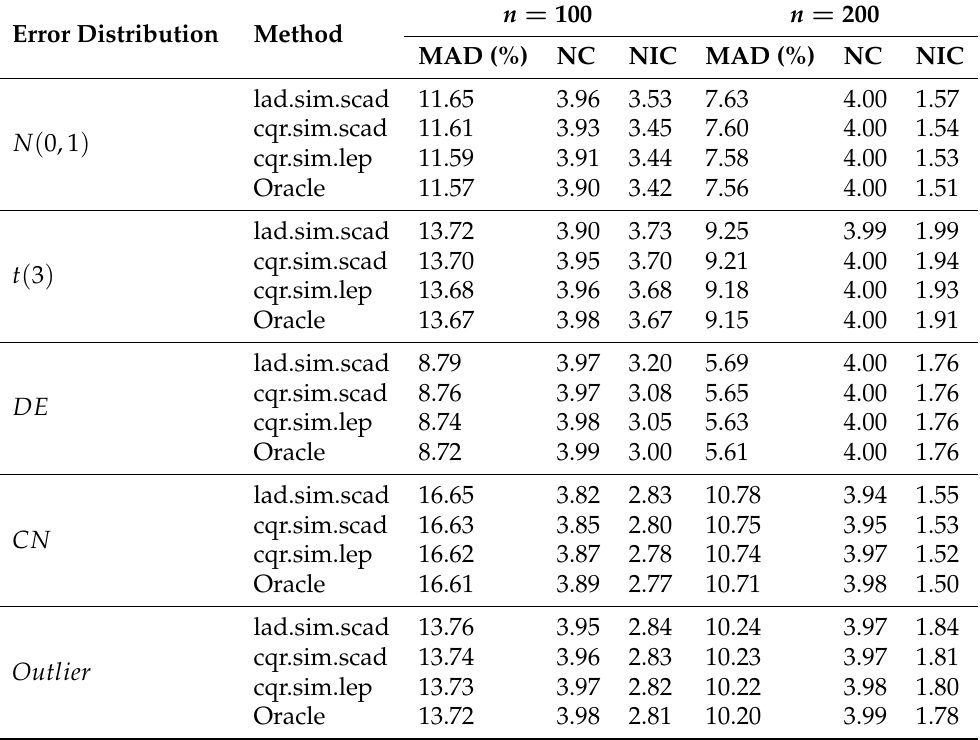
Table 1. Simulation results for Scenario 1 based on 200